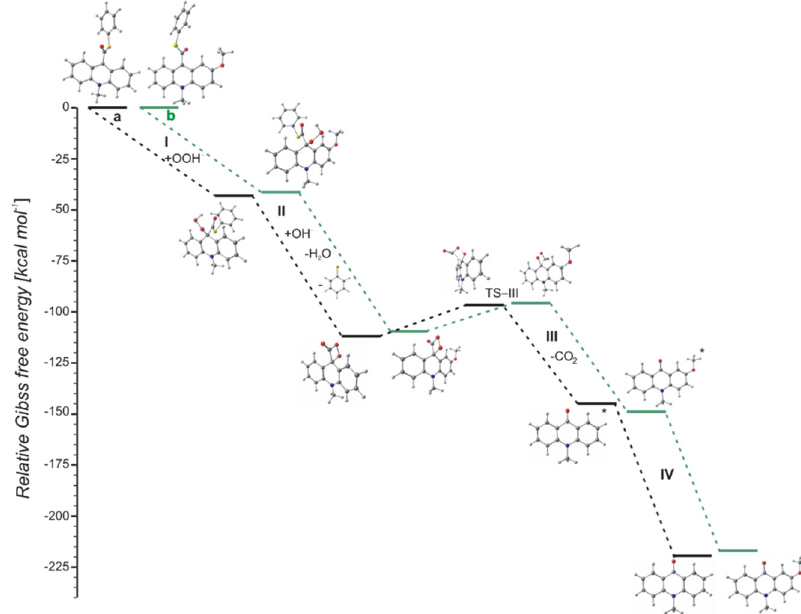
Figure 2. Relative Gibbs free energies of the chemiluminescence (CL) reaction steps (CL pathway) of acridinium thioesters: ( a , black) unsubstituted and ( b , green) substituted in the acridine moiety.